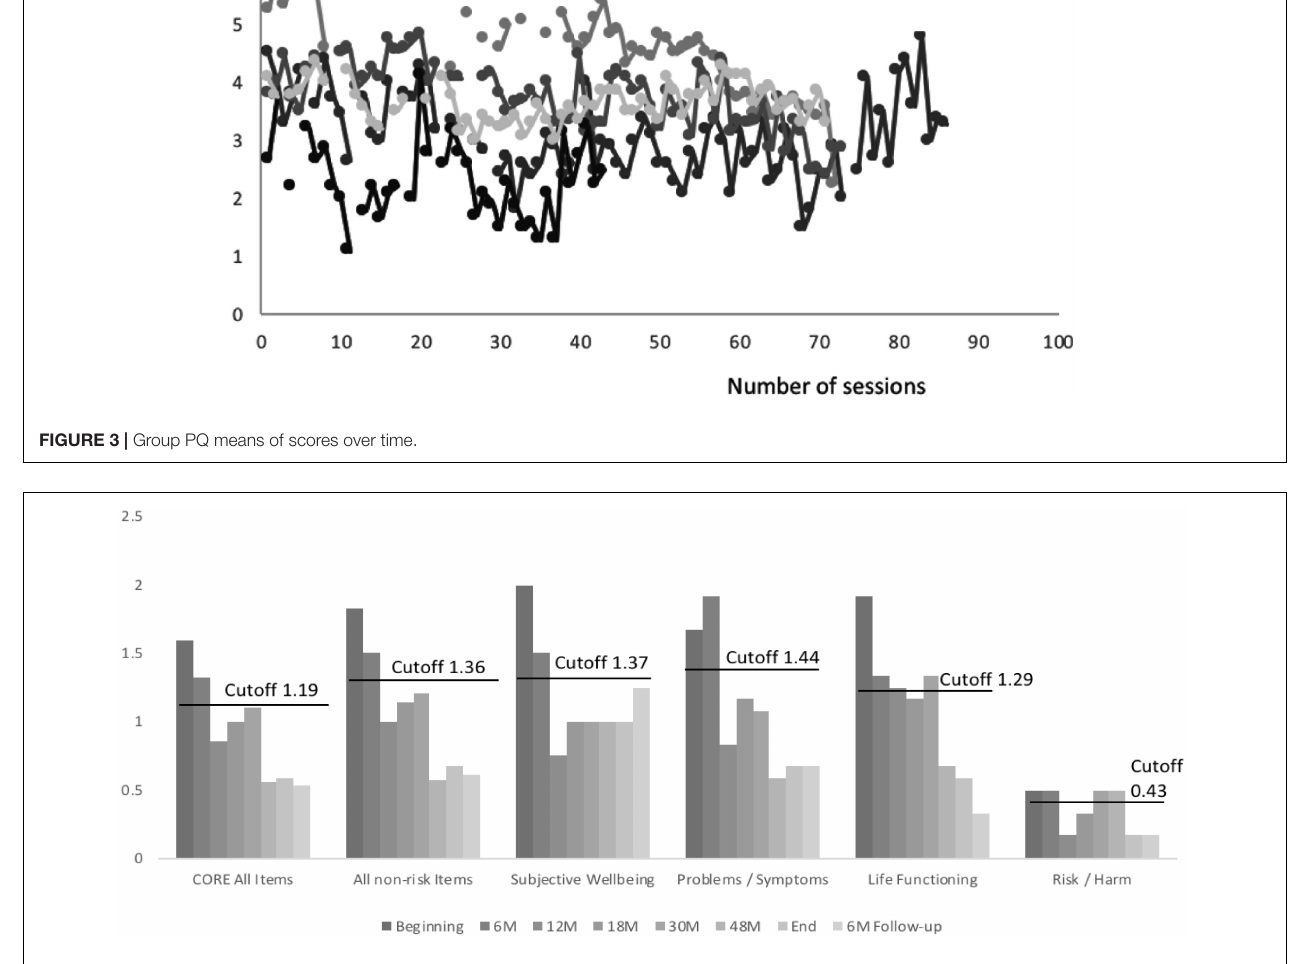
FIGURE 4 | John’s evolution in CORE scales over time. M, months in